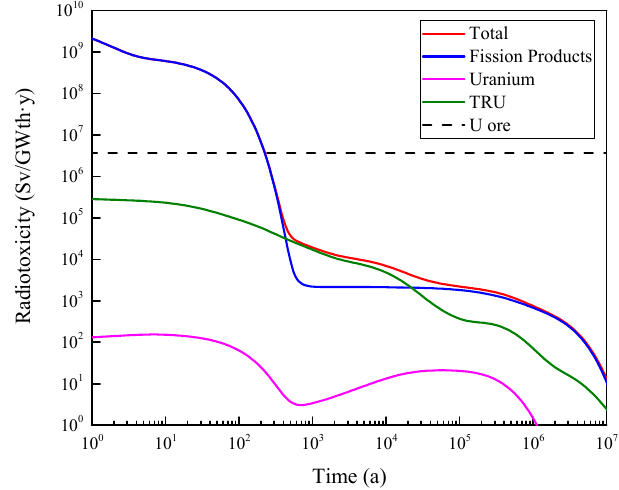
Figure 13. Radiotoxicity of FP wastes.